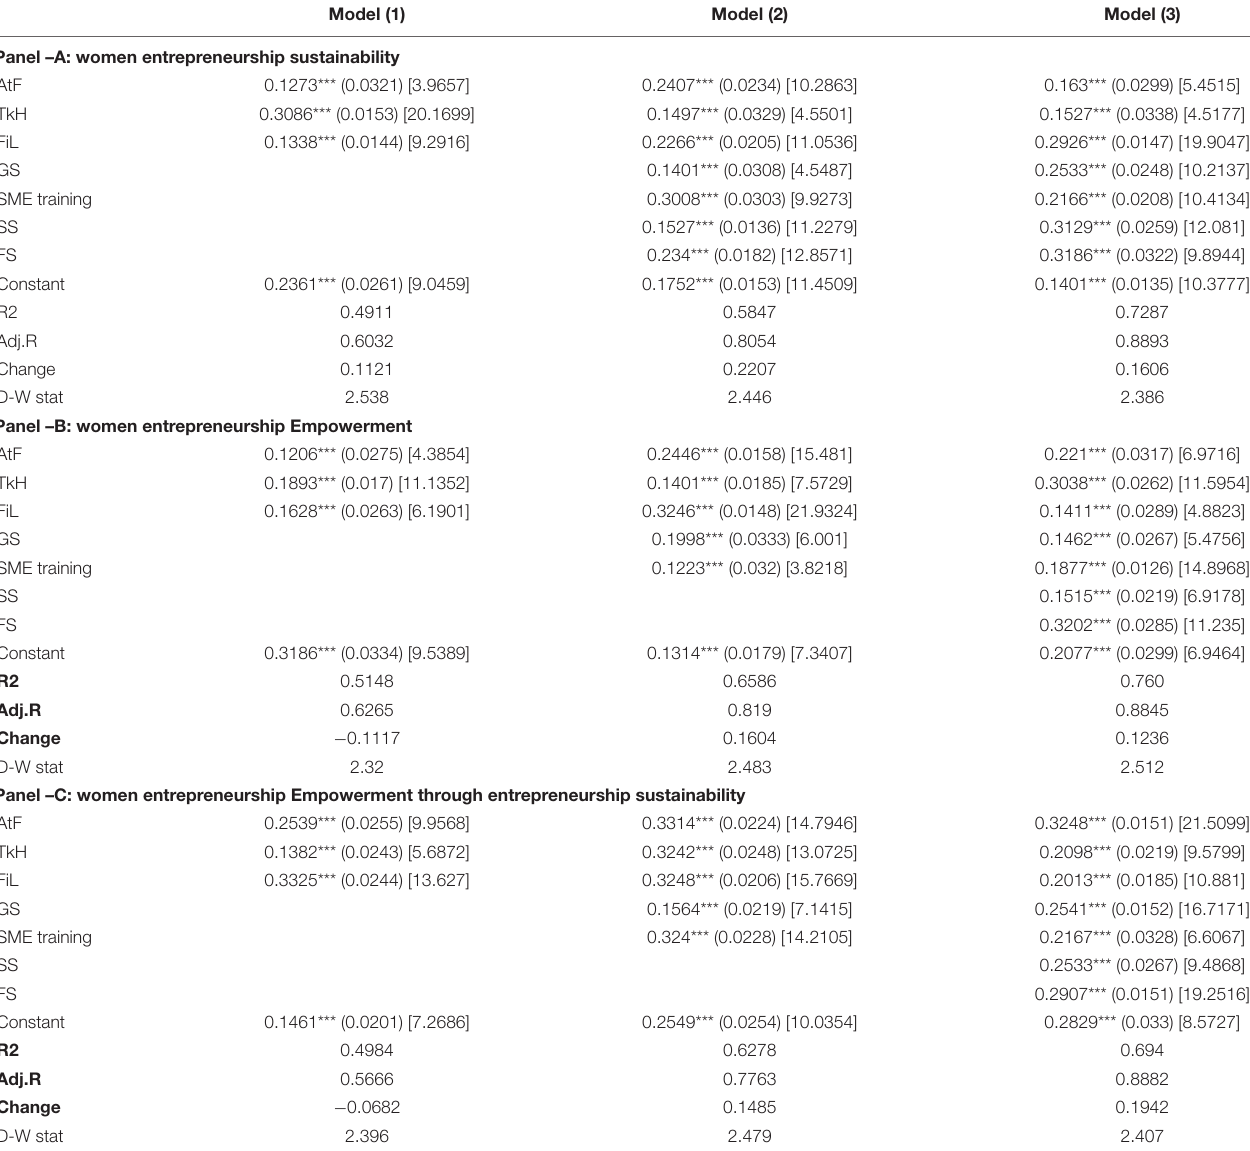
TABLE 10 | Hierarchical regression